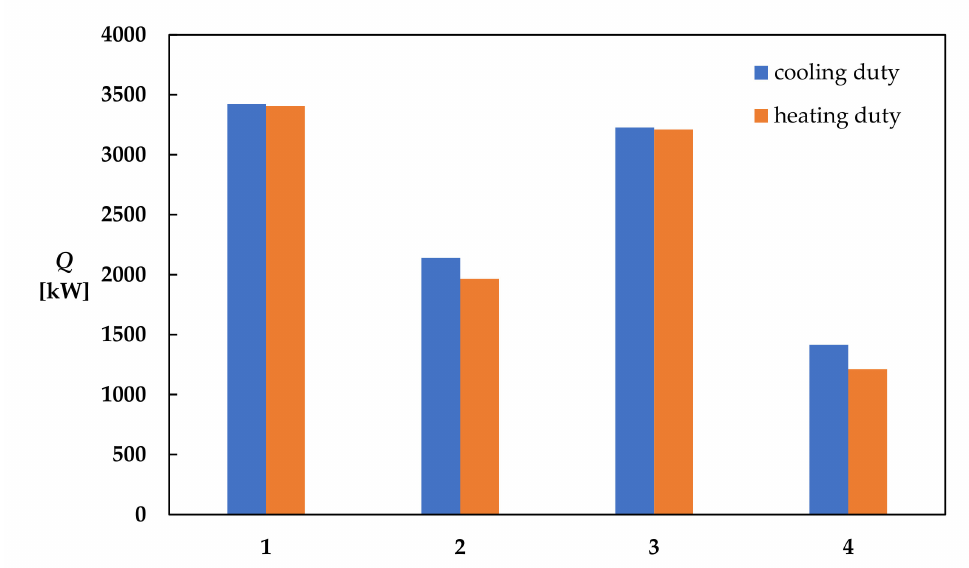
Figure 8. MVRHP effect on overall energy requirements; 1—conventional process (Figure 2), 2—conventional process with an MVRHP (Figure 4), 3—RD column with a separation unit (Figure 3), 4—RD column with a separation unit and an MVRHP (Figure 6).